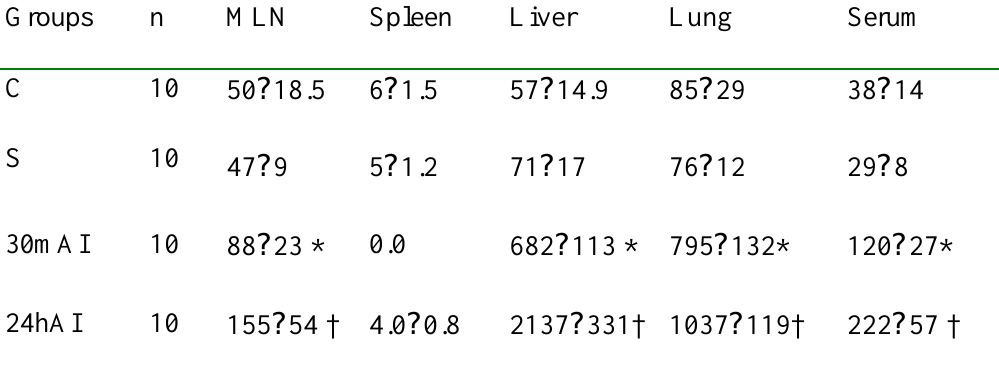
TABLE 1 - Level of radioactivity (mean counts per minute per gram) from MLN, Spleen, Liver, Lung and Serum after 99m Tc E. coli translocation